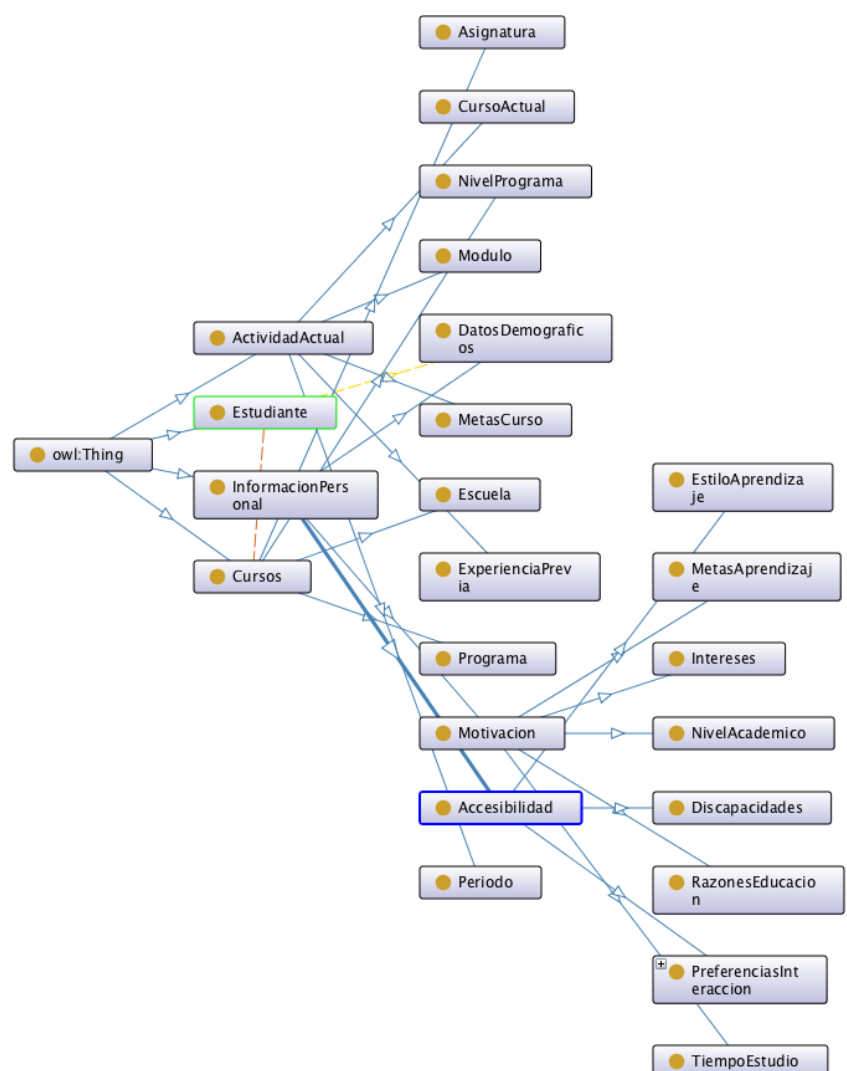
Figure 9. Graph of classes of the ‘OntoOAIStudent.owl’ ontology.